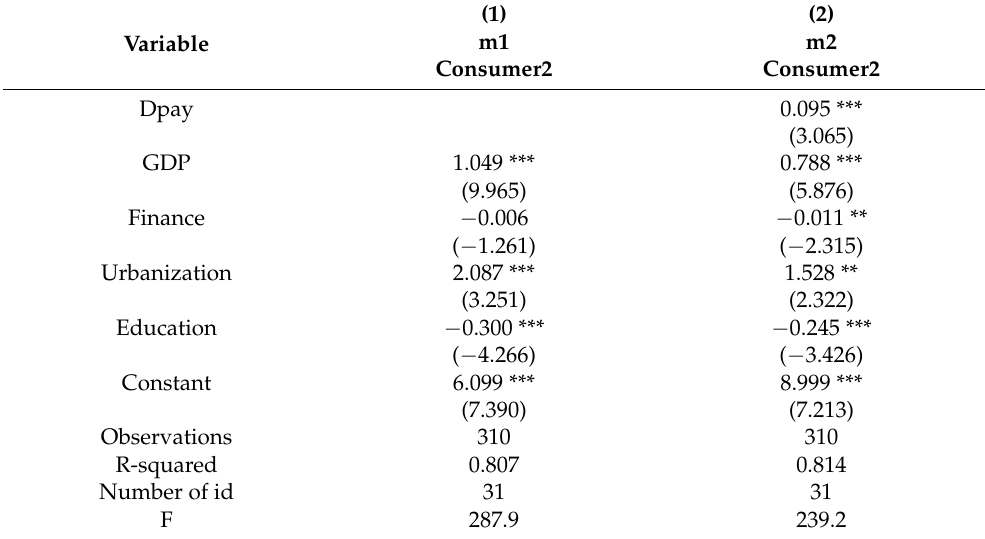
Table 9. Robustness analysis: variable substitution method.